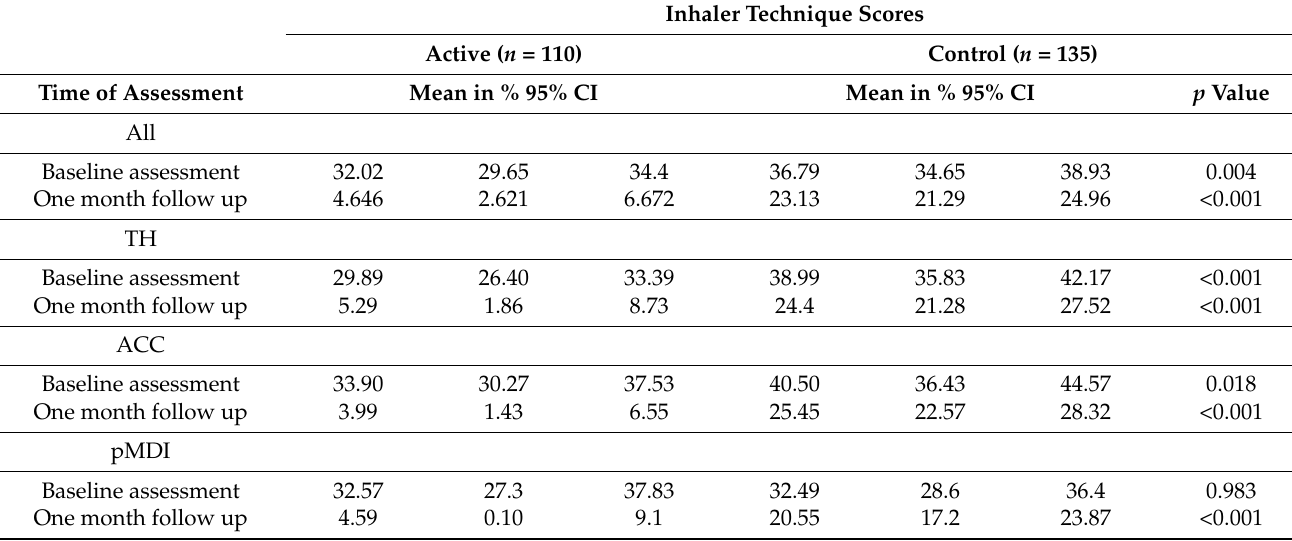
Table 4. Inhaler technique scores for patients in the active and control groups.